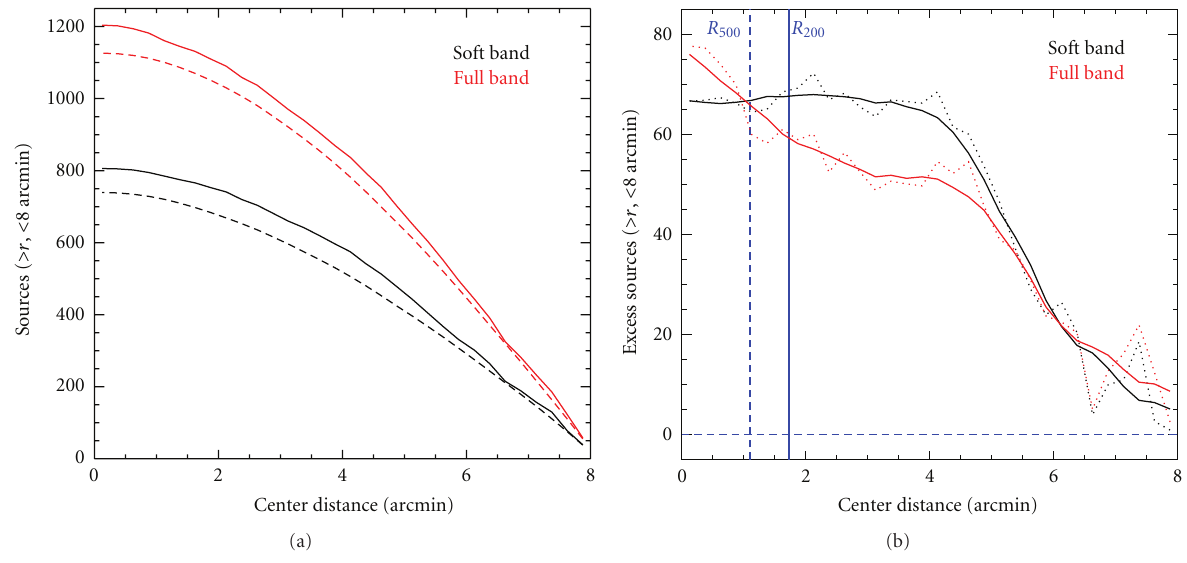
Figure 5: Cumulative number count distributions starting from an o ff -center angle of 8 (cid:3) inwards. (a) Total cumulative counts for cluster fields (solid lines) in comparison to the median background models (dashed lines) for the soft-band (black) and full-band detection (red). (b) Cumulative distribution of excess counts after subtraction of the background model for the soft band (black) and full-band (red). Dotted lines show the original measured distribution, whereas solid lines depict the smoothed trends after boxcar filtering. Average cluster radii R 500 (dashed) and R 200 (solid) for the distant cluster sample are marked by the blue vertical